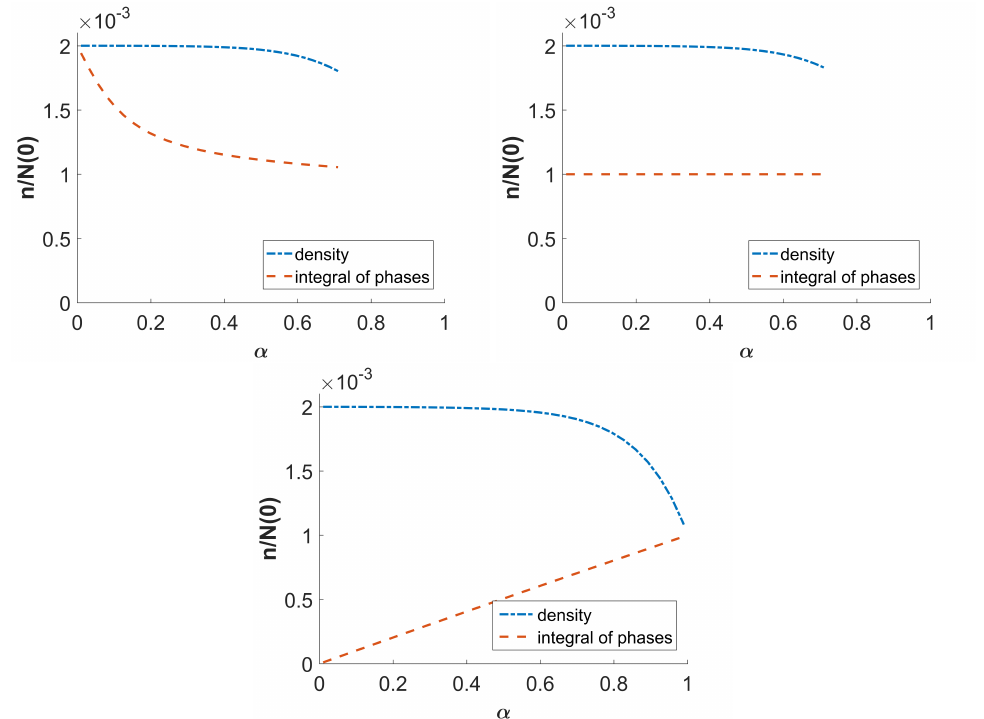
Figure 6: Comparison plots of the fermion density and the integral of the phases for 0 < α < 1 with (a) λ = 0.7, (b) λ = 1, and (c) λ = 100. Other parameters used in generating these plots are E = 1 and W = 0.001 E . With these parameters and α in the range shown in the plots, Eq. 37 is satisfied. n in n / N ( 0 ) labeled on the vertical axis is a nominal symbol for the fermion density or the integral of the